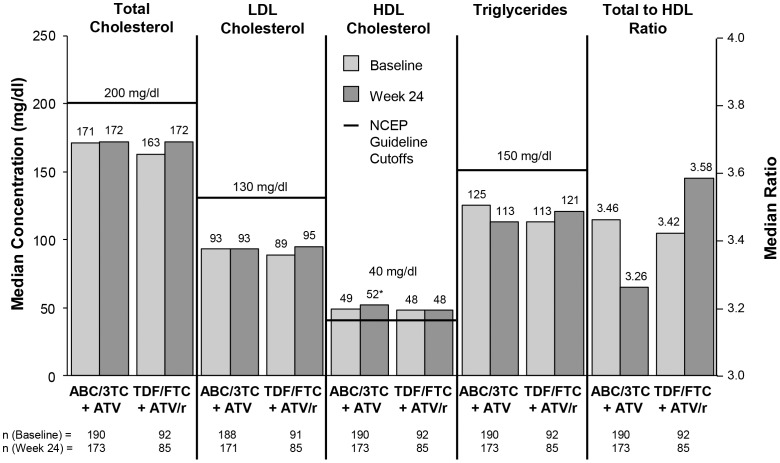
Median fasting lipid parameters with guideline cutoffs from the National Cholesterol Education Project (NCEP) [17].*P<0.001 from baseline to Week 24.